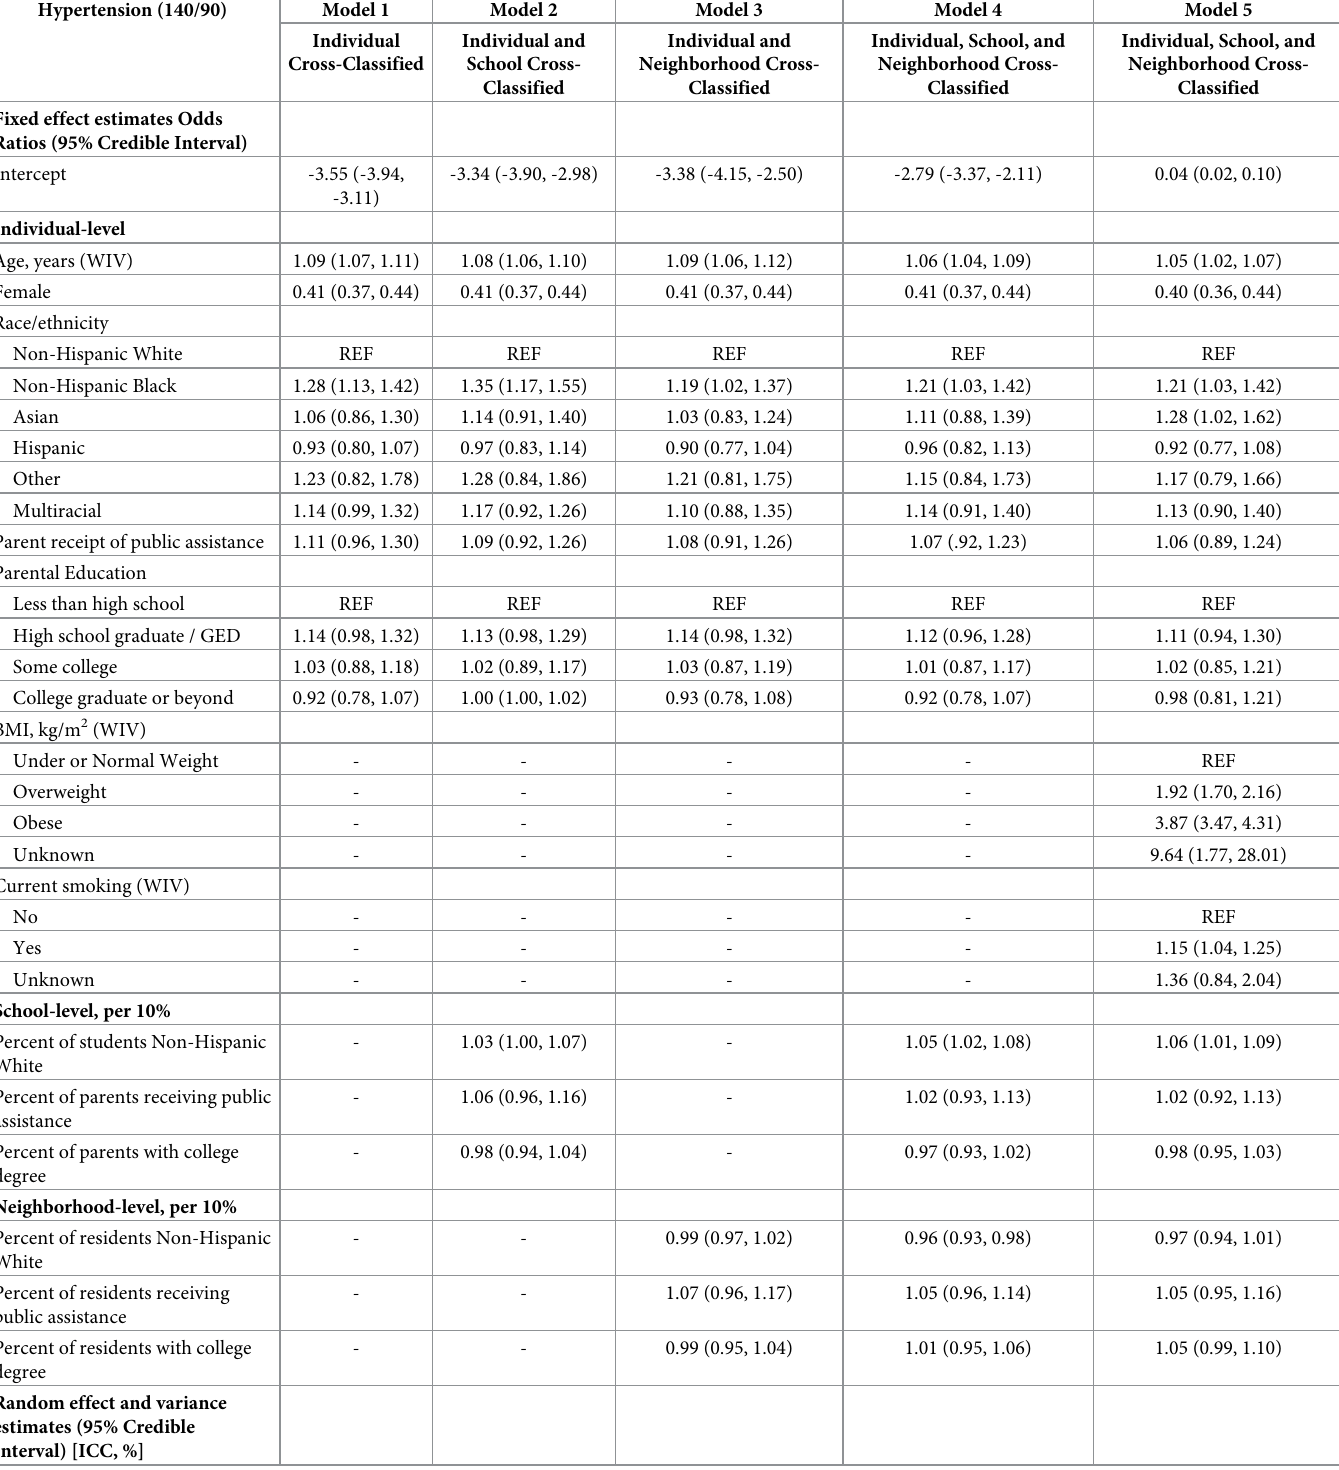
Table 2. Logistic cross-classified multilevel models (CCMM) predicting hypertension from individual-, school- and neighborhood-level factors in the National Lon- gitudinal Study of Adolescent to Adult Health, Wave IV (WIV), 2008–2009 (N =